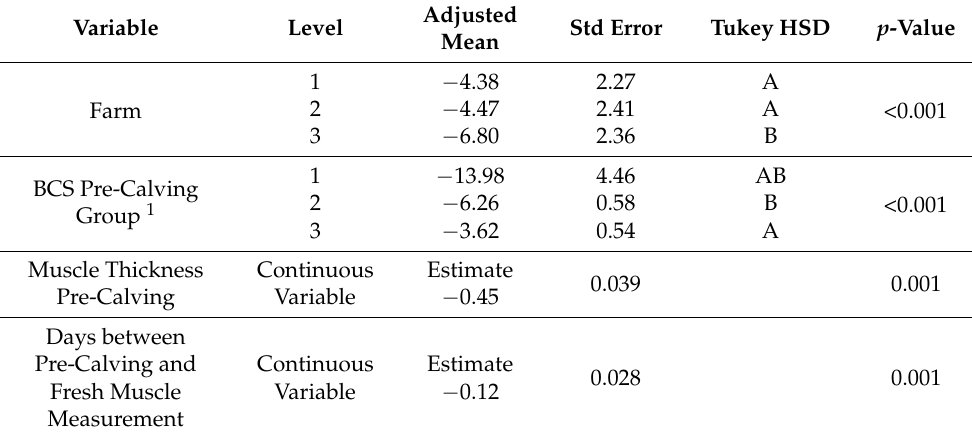
Table 2. Results from a multivariable mixed effects linear regression model for outcome muscle thickness (mm) pre-calving to fresh (negative values describe loss of MT). Estimates for continuous describe the change in the outcome variable per one unit increase in the explanatory variable. HSD: Honestly significant difference; levels within a variable with different letters are statistically significantly different ( p <